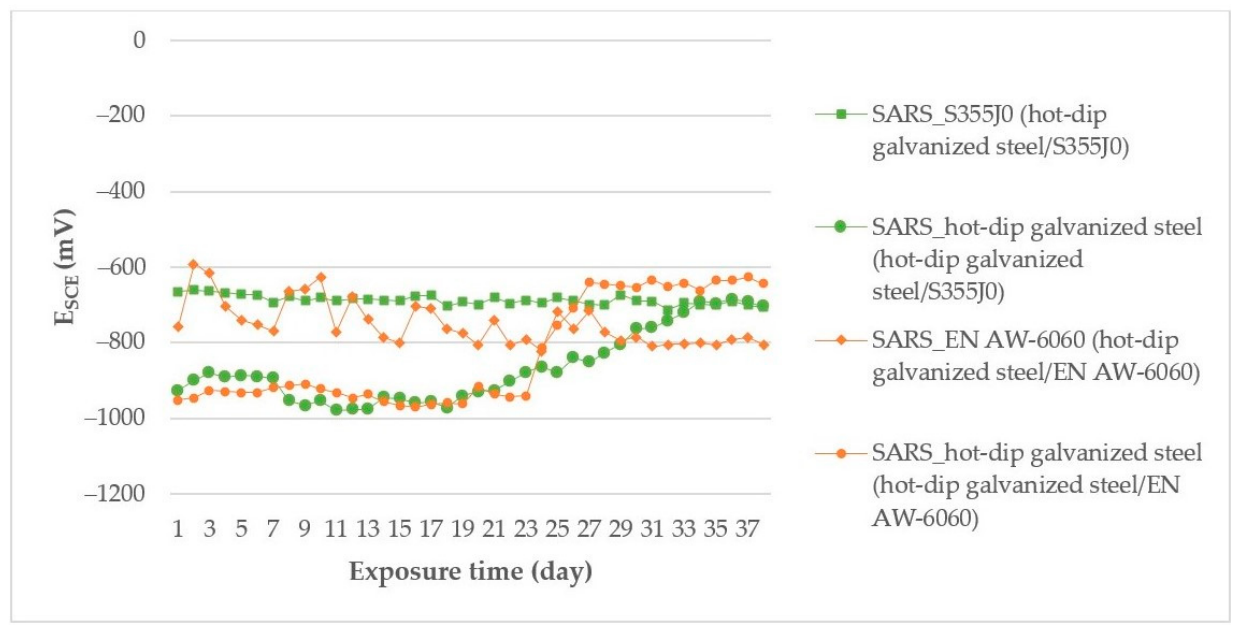
Figure 3. E SCE measurement results for bimetallic couples exposed in SARS.